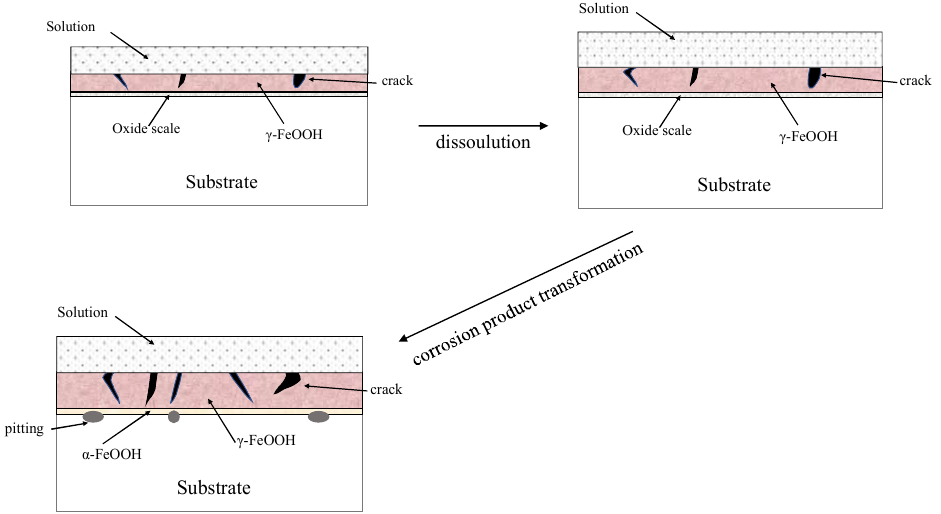
Figure 12. Corrosion mechanism of ER8 wheel steel in solution.